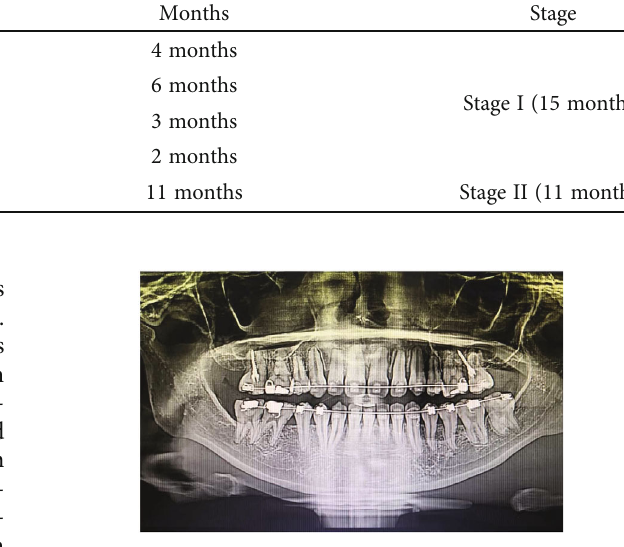
Figure 3: Midtreatment OPG showing OIEARR varying from moderate to severe in maxillary teeth and mild in mandibular